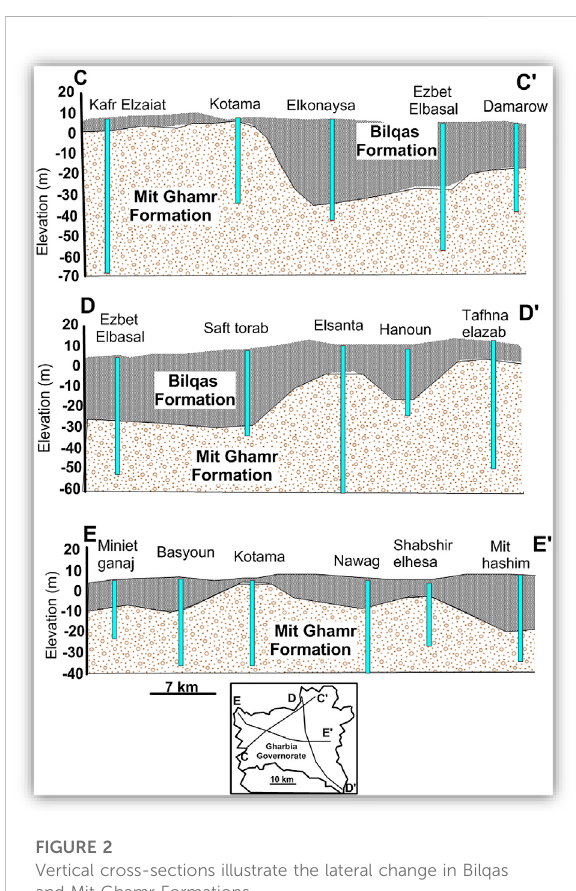
FIGURE 2 Vertical cross-sections illustrate the lateral change in Bilqas and Mit Ghamr